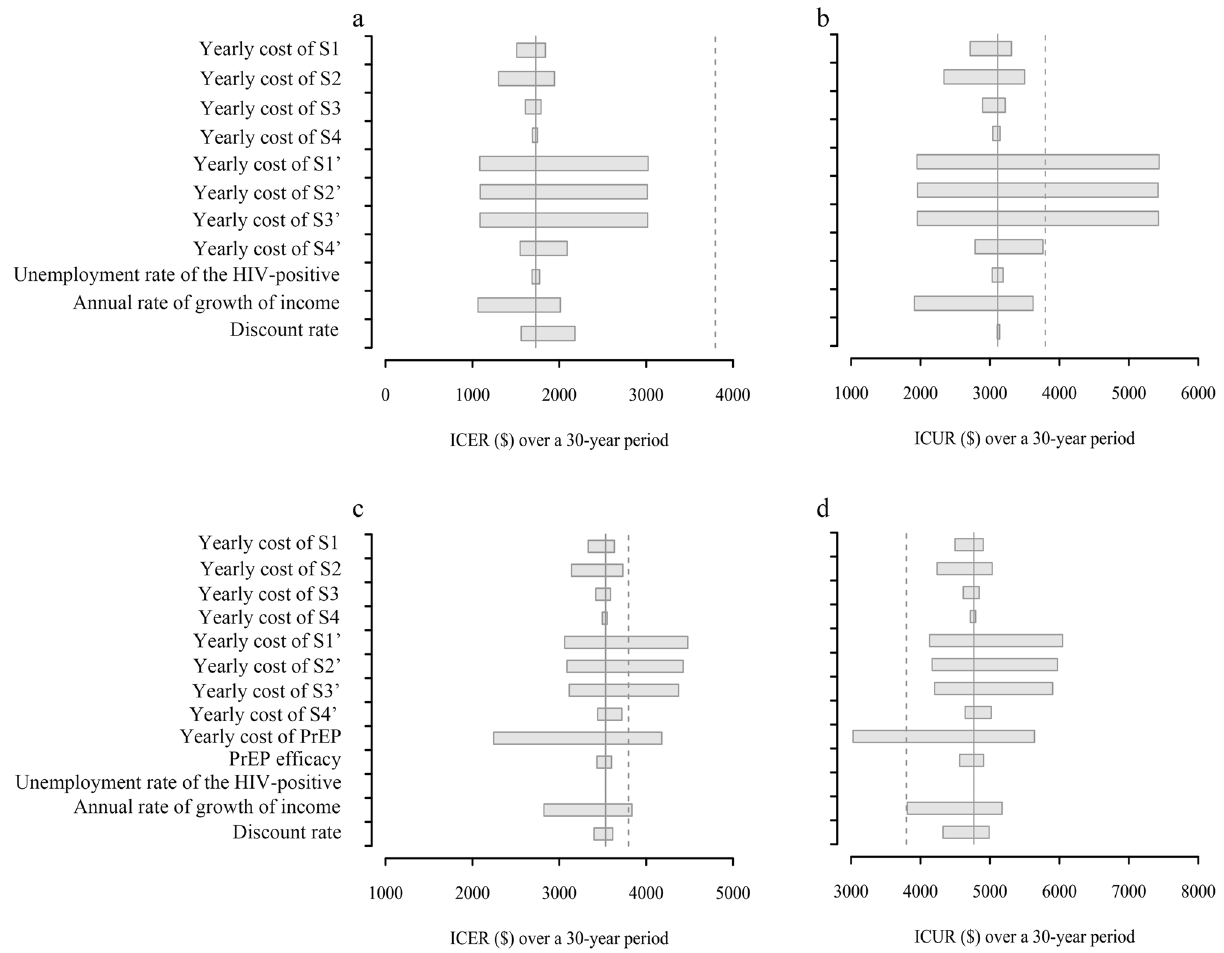
Figure 5. Outcomes of one-way analysis. We calculated the impacts of specific cost and transmission-related variables on ( a ) ICER in early-ART versus late-ART; ( b ) ICUR in early-ART versus late-ART; ( c ) ICER in short-term PrEP + early-ART versus late-ART; ( d ) ICUR in short-term PrEP + early-ART versus late-ART, over a 30-year period. The solid vertical grey line represents the results of the base case. The dashed vertical grey line represents the threshold ($3797) for being very